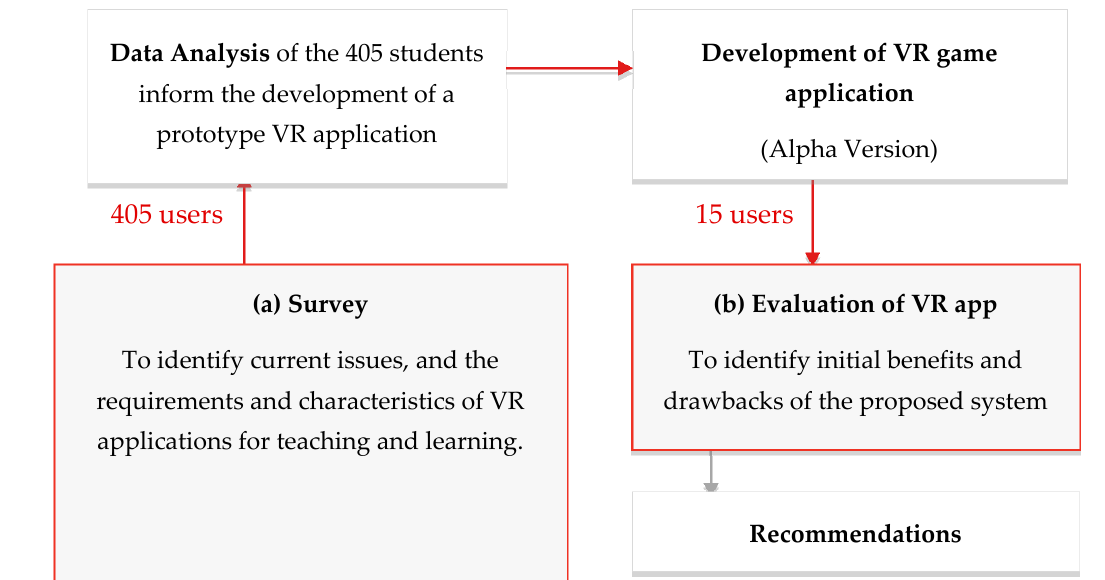
Figure 2. Two-stage experiment structure: ( a ) survey—405 students, and ( b ) preliminary evaluation of prototype VR application.